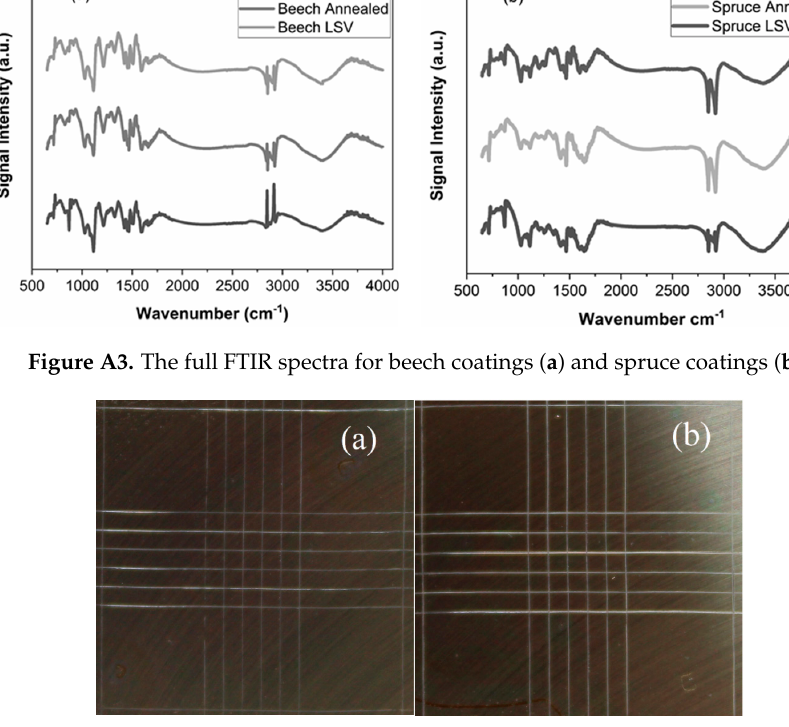
Figure A4. Surface of annealed spruce coating ( a ) and beech coating ( b ) after conducting crosscut test, according to ISO 2409. No sign of coating’s detachment from the square lattices was observed.